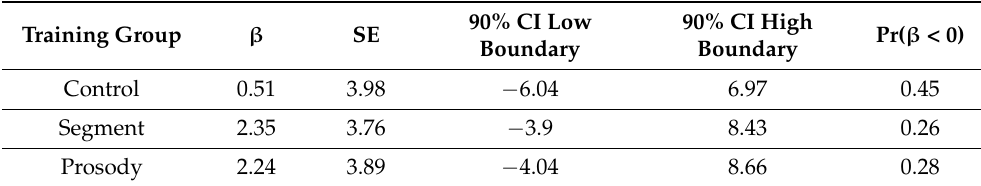
Table 7. Statistical results for vowel duration distance.